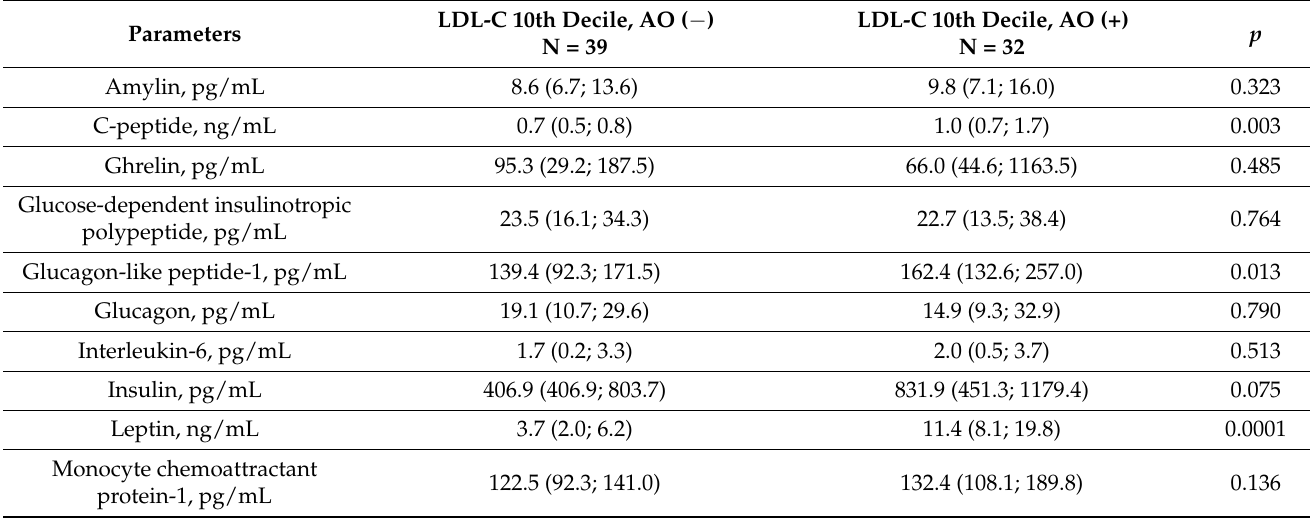
Table 3. Analysis of blood levels of adipokines/cytokines associated with the secretory activity of visceral adipocytes in women with hyper-LDL-C with and without AO (Me (25%;